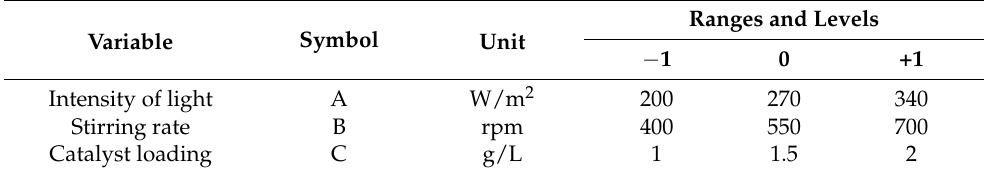
Ranges and Levels